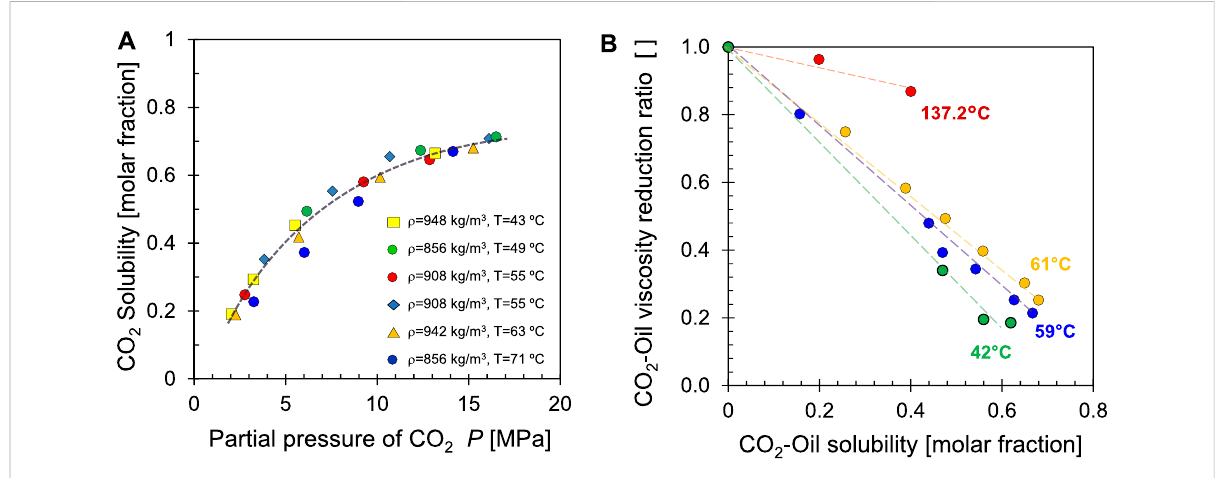
FIGURE 20 CO 2 and oil. (A) Solubility as afunction ofCO 2 partial pressure for differenttemperatures.Data source:Simon and Graue.,1965. (B) Oilviscosity with increasing molar fraction of dissolved CO 2 . Data source: Barclay and Mishra., 2016.